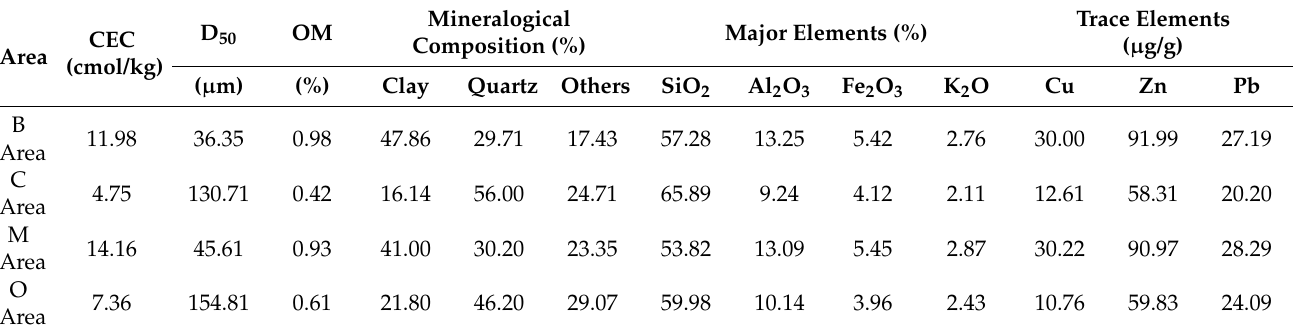
Table 1. Mean values of physicochemical parameters of sediments from various locations of Yangtze